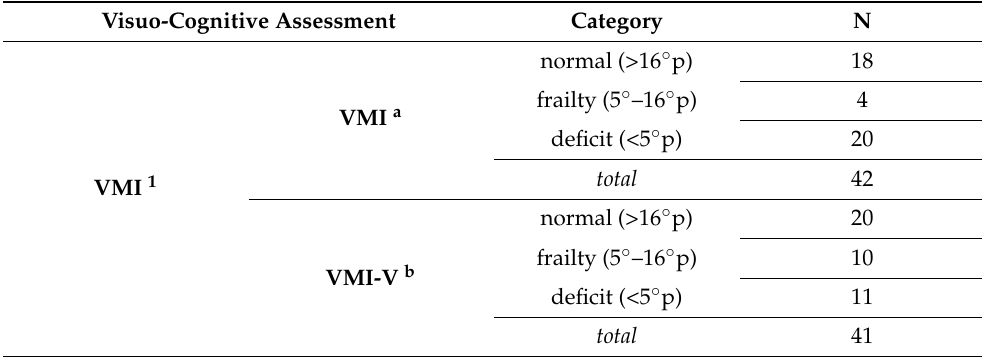
Table 4. Cognitive visual assessment. N indicates the number of subjects who performed the test or had interpretable